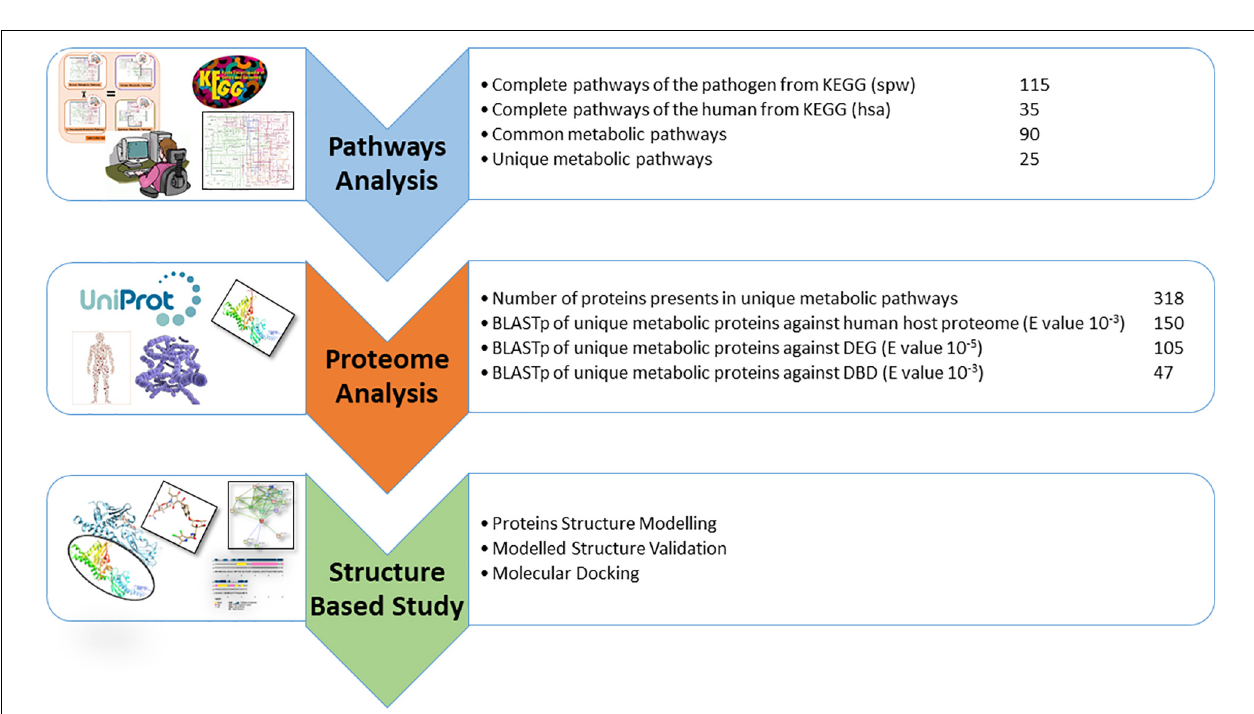
FIGURE 3 | Current study summary for target protein identification: Stepwise analysis of subtractive genomic approach for drug targets identification in S. pneumoniae .